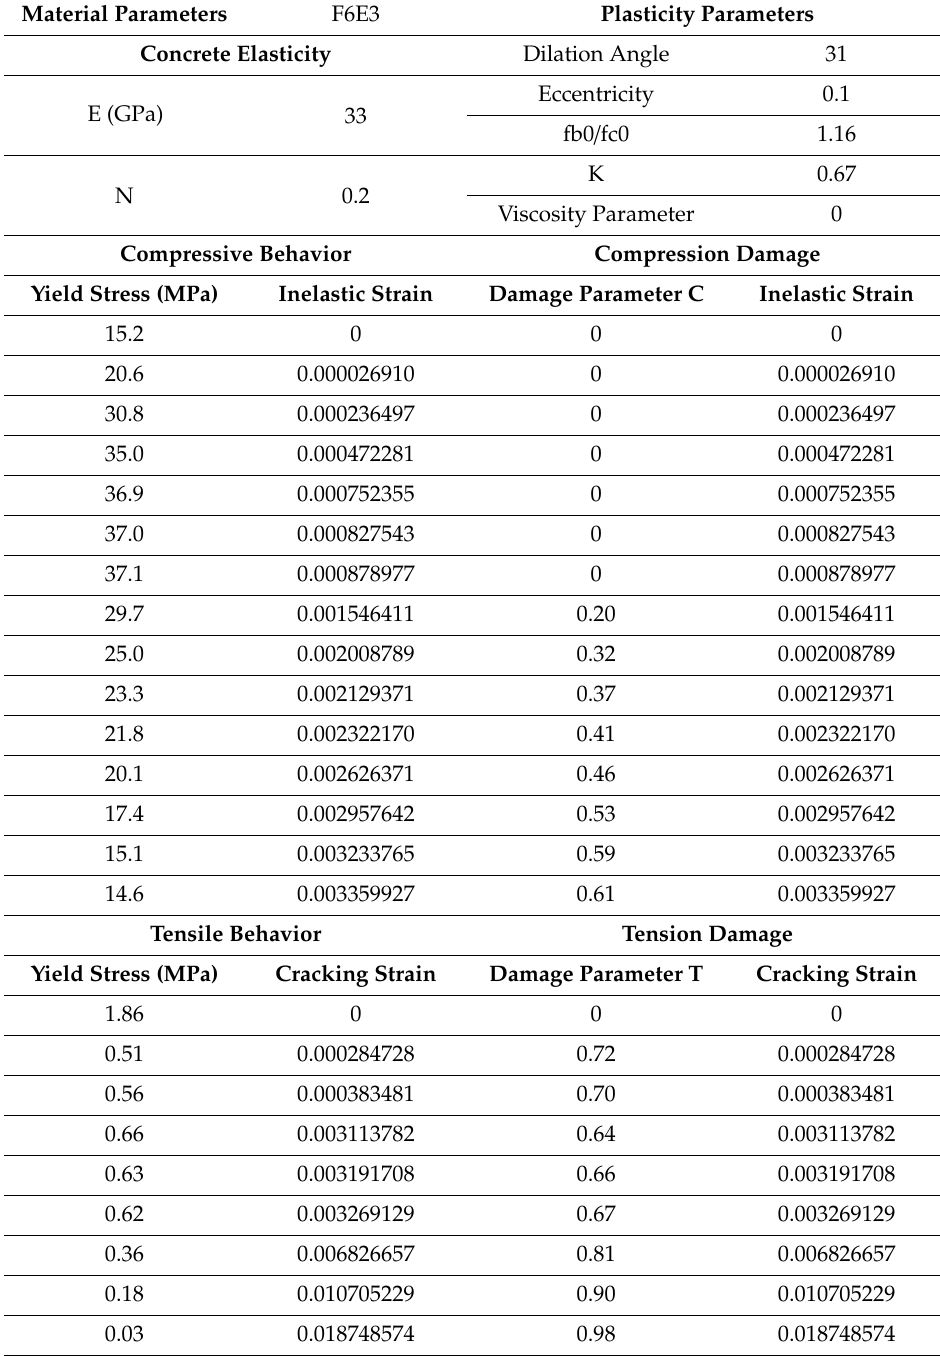
Table 10. Material properties of F6E3